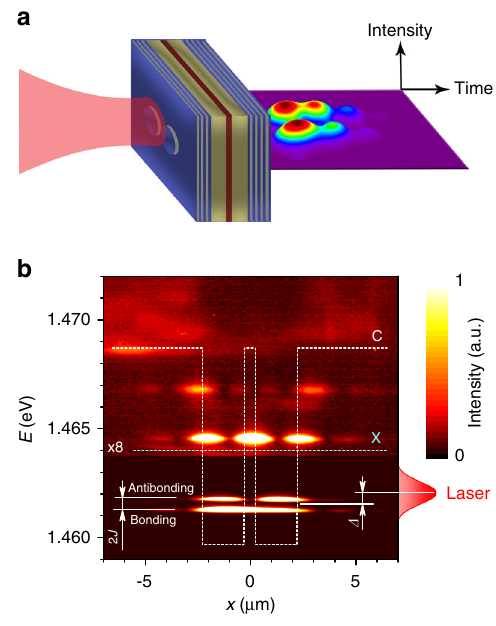
Fig. 1 Polariton Josephson junction. a Schematic of the microcavity with two coupled mesas, one of which is predominantly illuminated, and the resulting Josephson oscillations of exciton-polaritons. b Spectrum of polariton emission from two coupled mesas under nonresonant continuous-wave excitation. Dashed curves represent the energies of the exciton (X) and cavity (C) modes. Coupling of mesas with J = 0.4 meV leads to formation of bonding and antibonding states. During the experiments, only these states are resonantly excited with pulsed laser, schematically shown on the right. Δ = ω c − ω laser is the laser